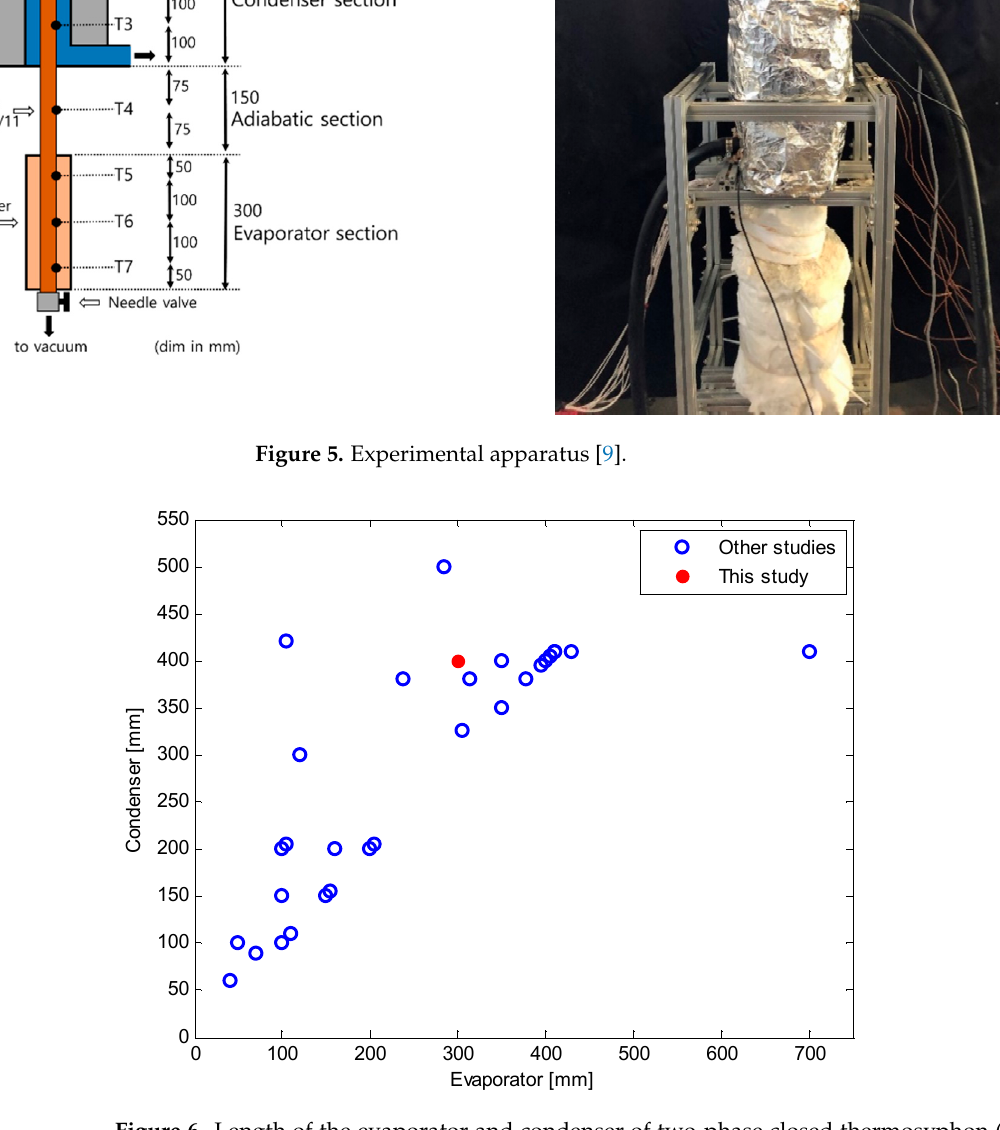
Figure 6. Length of the evaporator and condenser of two-phase closed thermosyphon (TPCT) in previous studies.